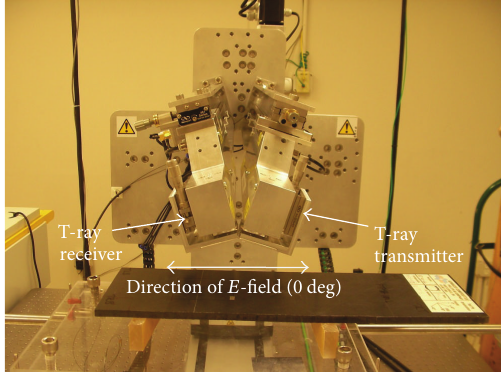
Figure 11: Diagram showing a sample set up system.